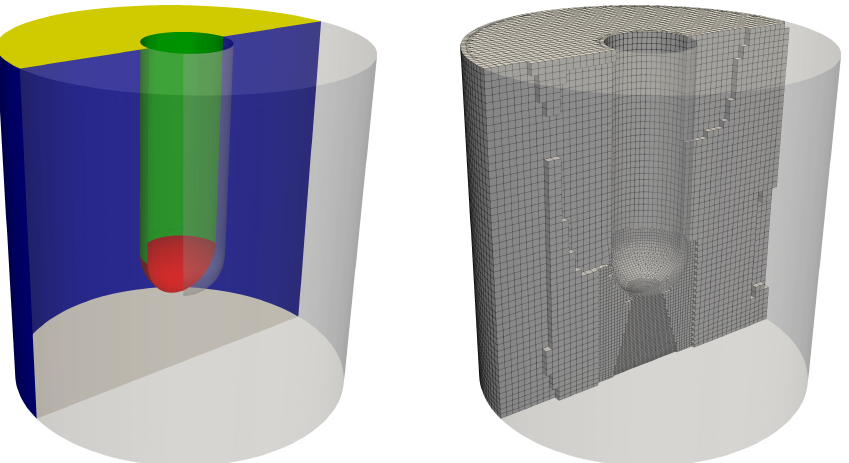
Figure 5. Example of model geometry and mesh used in MHD-CFD simulations. The boundary surfaces are shown at left—red is the cathode, grey is the anode, green is the electrode wall, blue is the vessel wall, and yellow is the vessel atmosphere.